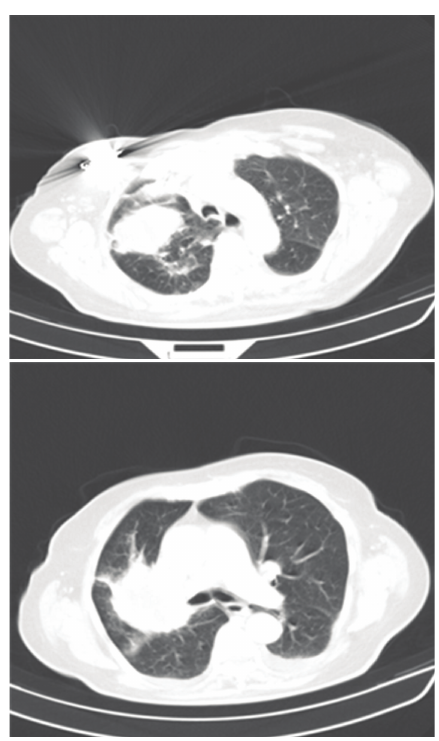
Figure 2: Chest tomography showing a suprahilar right lung mass, ill defined, thick walled, and irregular, centered in upper lobe bronchus, which is obliterated, probably due to tumor necrosis.